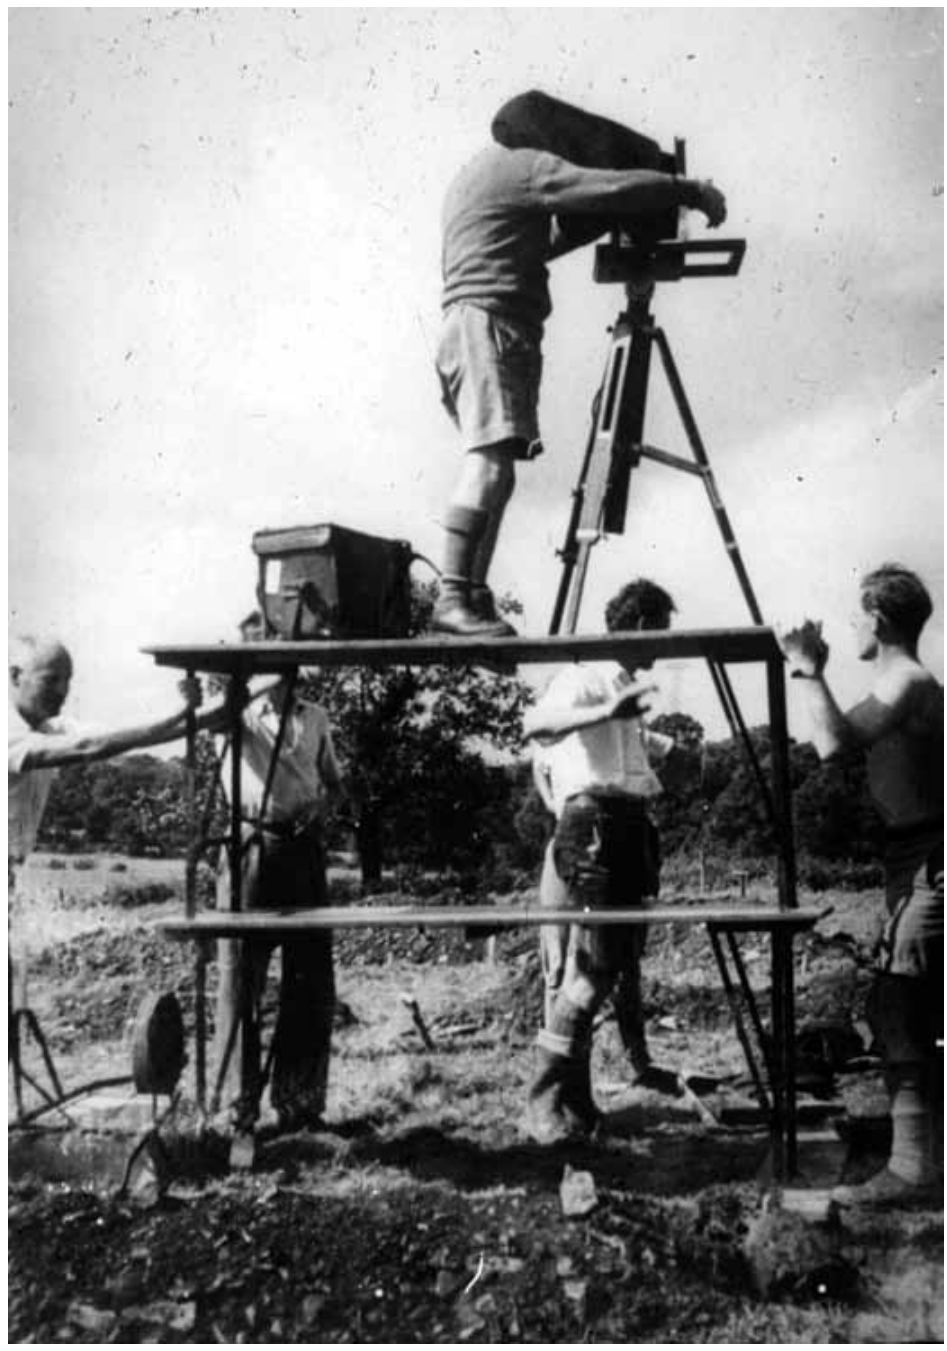
Fig. 4: ‘Cookie’ Cookson (under camera hood), photographing Institute of Archaeology exca- vations at Maiden Castle, Dorset, c.1950s; from a 6cm square conventional negative shot with a twin lens reflex camera (image courtesy of Stuart